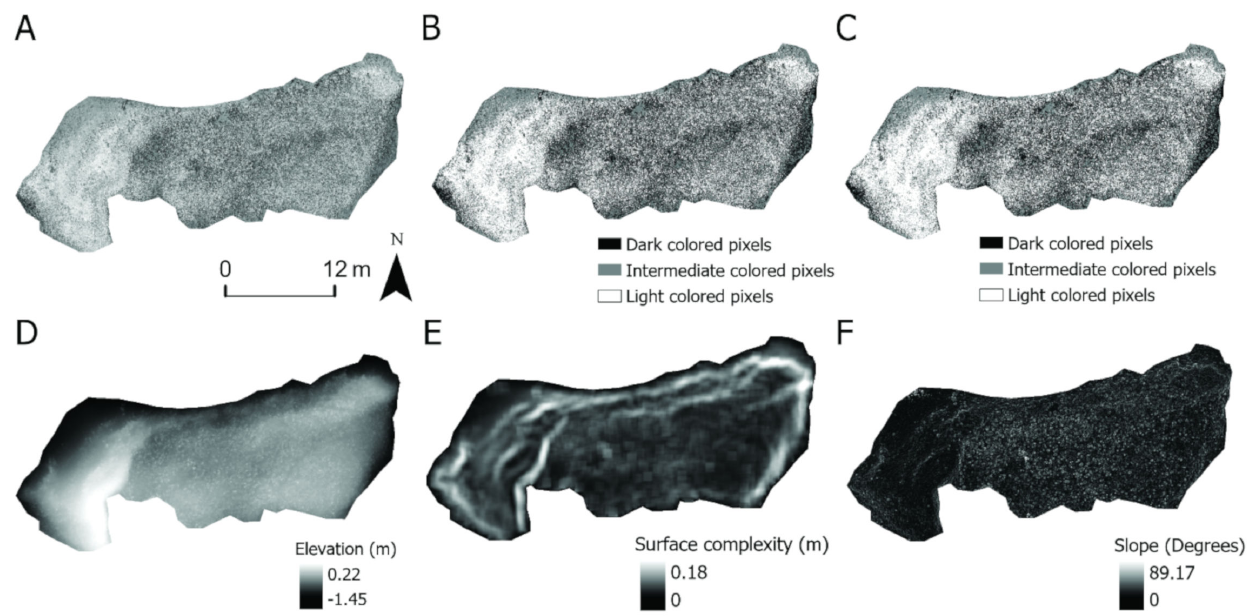
Figure A2. Spectral and structural geospatial analyses applied to a patch reef located on Town Marsh (TM 4). ( A ) RGB orthomosaic with pixel resolution of 0.0062 m. ( B ) Unsupervised classification on RGB orthomosaic. ( C ) Unsupervised classification on segmented RGB orthomosaic. ( D ) Digital elevation model with pixel resolution of 0.0062 m. ( E ) Surface complexity (neighborhood standard